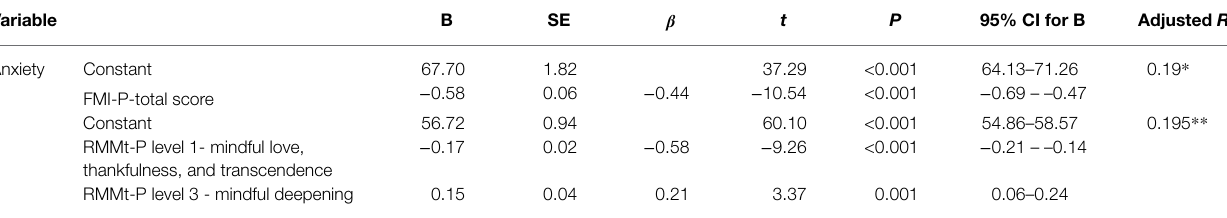
TABLE 4 | Comparison of the linear regression models of RMMt-P and FMI-P for predicting anxiety. Variable B